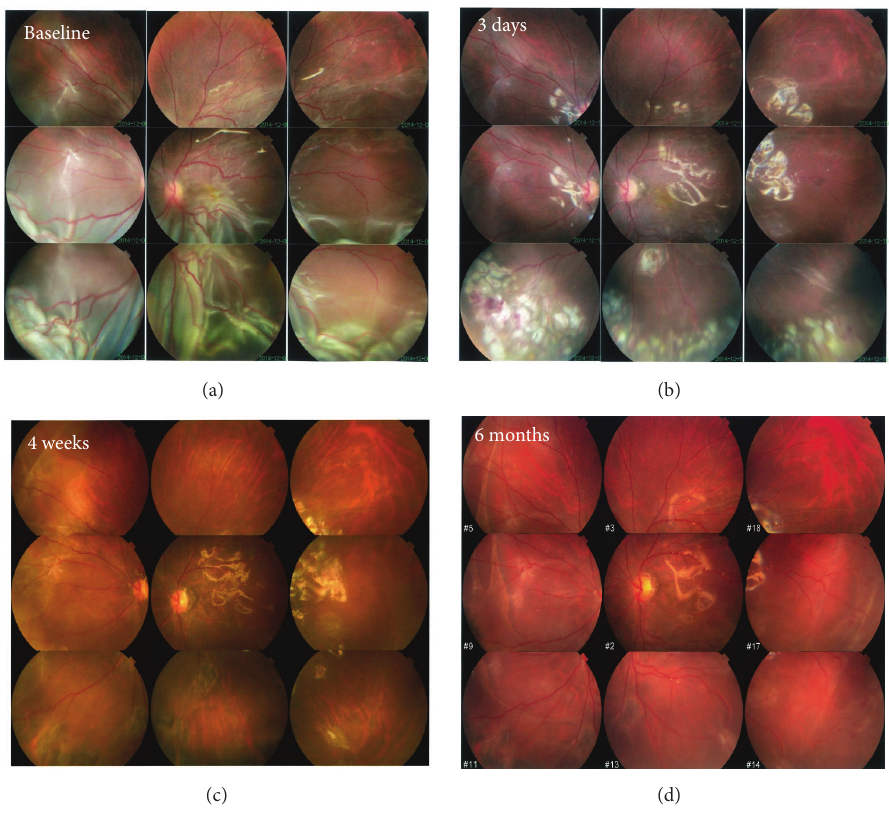
Figure 2: Serial fundus photographs of radial retinotomies with endodiathermy in a chronological order. (a) At baseline, a detached and shortened retina caused by severe PVR was observed. (b) During surgery, a series of retinotomies were created via endodiathermy, and the shortened retina was successfully relaxed. Three days after the operation, the white-marked edges of the retina, indicating the area of endodiathermy and endophotocoagulation, remained detectable. ((c), (d)) The retina was attached at 1 and 6 months after surgery, and no apparent PVR was observed.